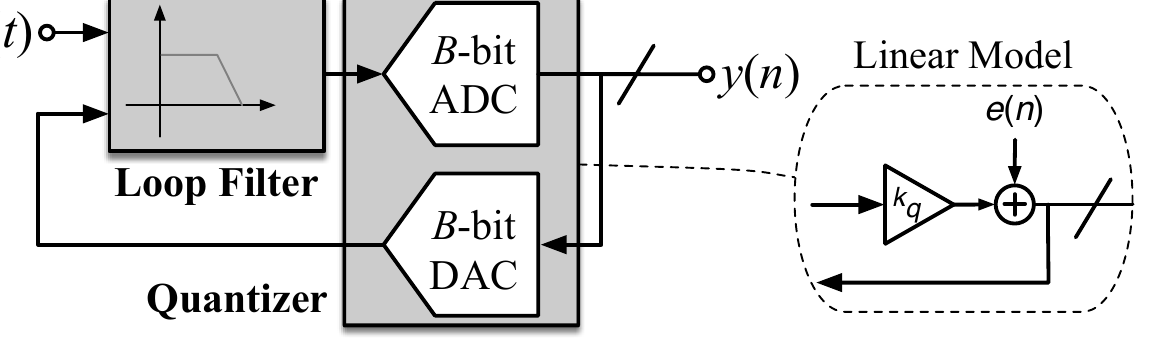
Figure 3. Conceptual block diagram of a Σ∆